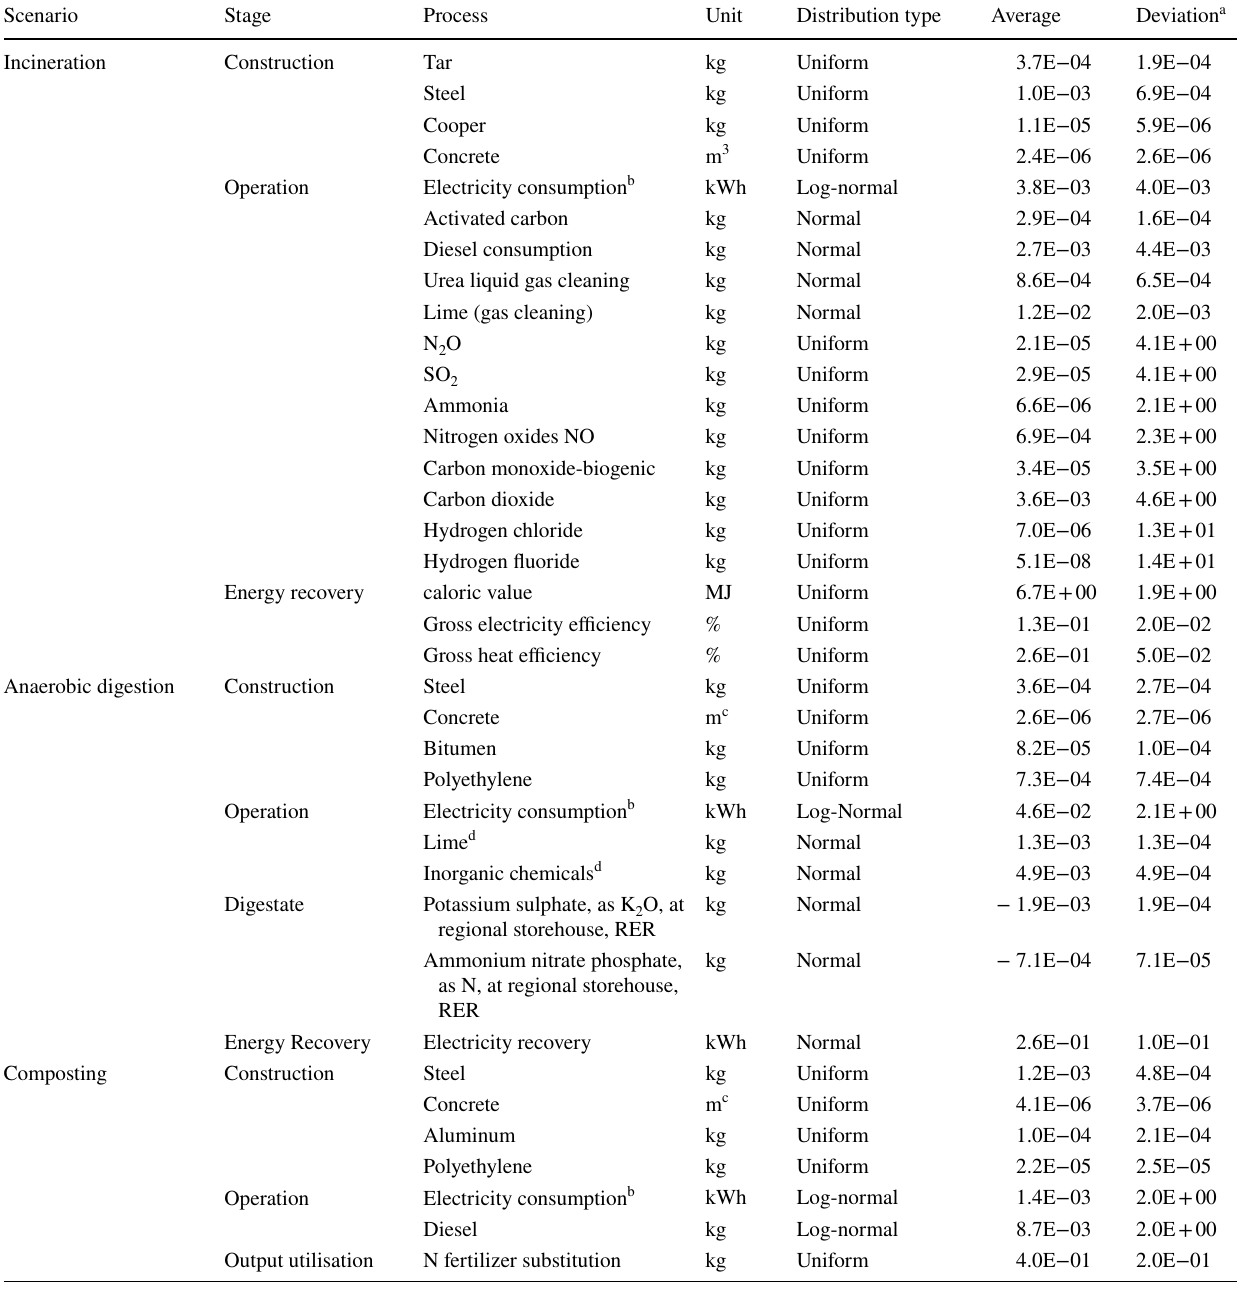
Table 2 Sensitivity analysis parameters for all